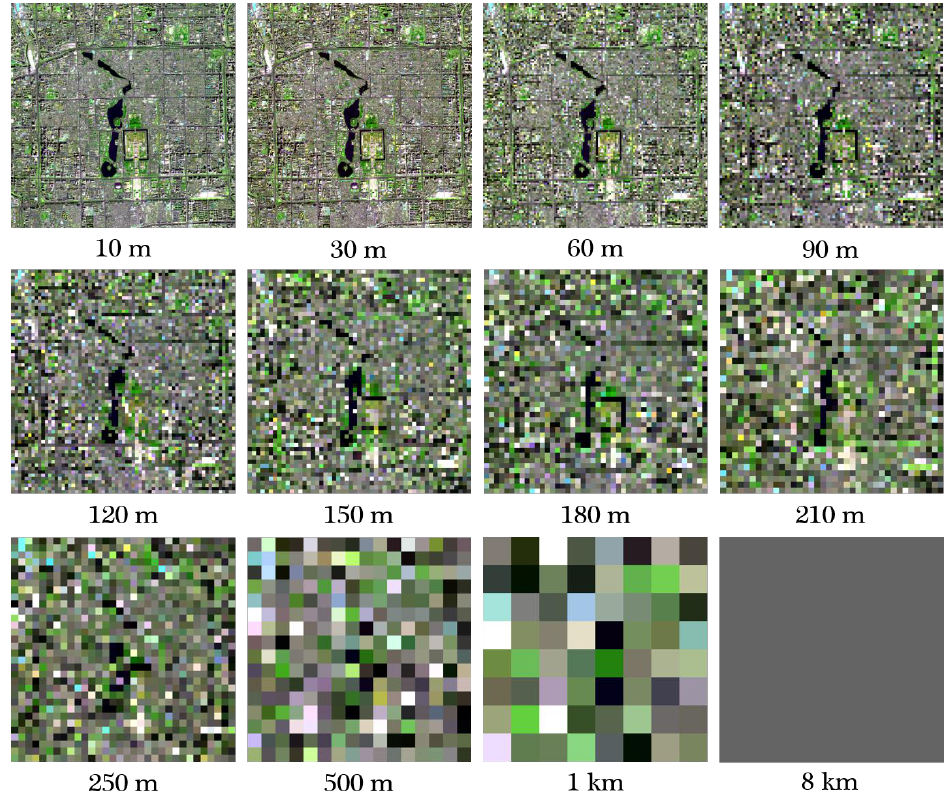
Figure 4. False color (Red, NIR, Blue bands as R-G-B) images of a sub-region in Beijing at different spatial resolutions.